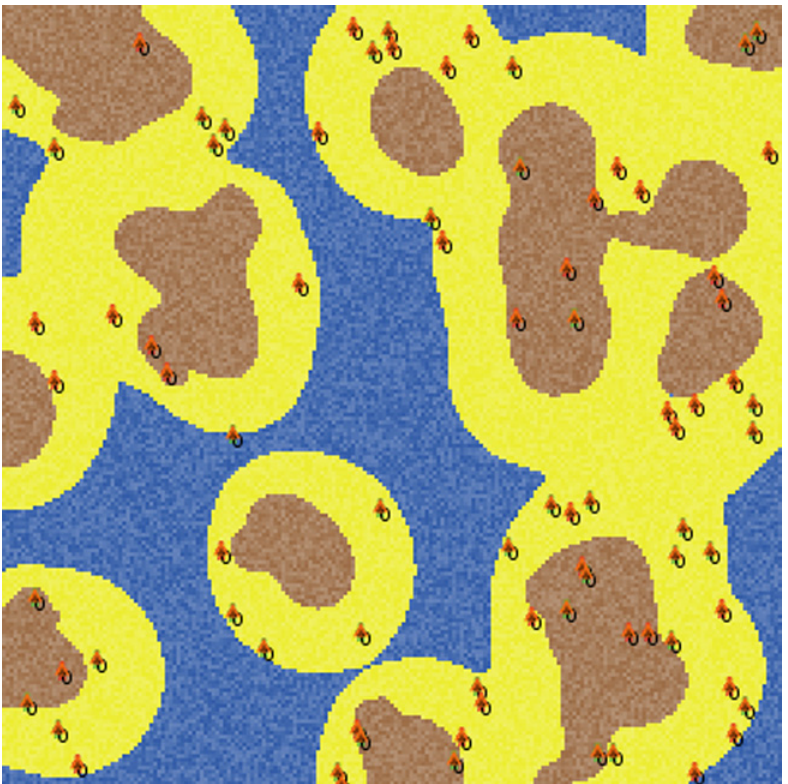
Fig 1. Snapshot of a 201x201 patch environment. Blue cells represent water, yellow represent beach and brown stands for land.